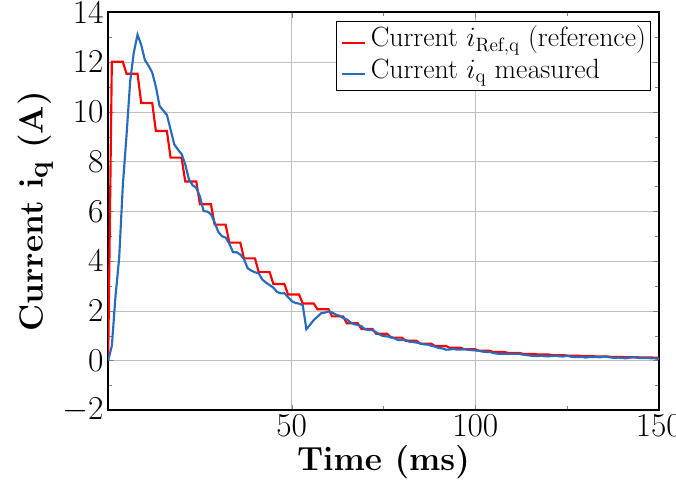
Figure 19. Sensorless speed control for 1200 RPM, current on the q-axis.